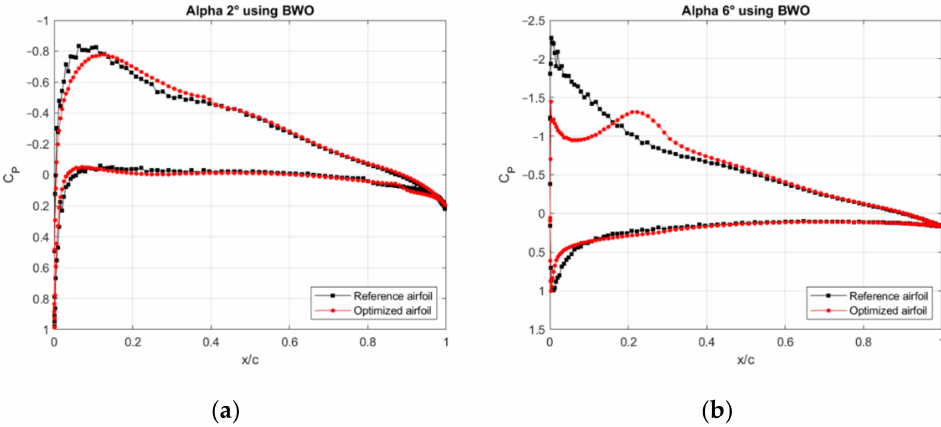
Figure 7. Cp distribution versus chord length using the BWO algorithm for the ( a ) angle of attack of 2° and ( b ) of 6°, compared to the reference airfoil.